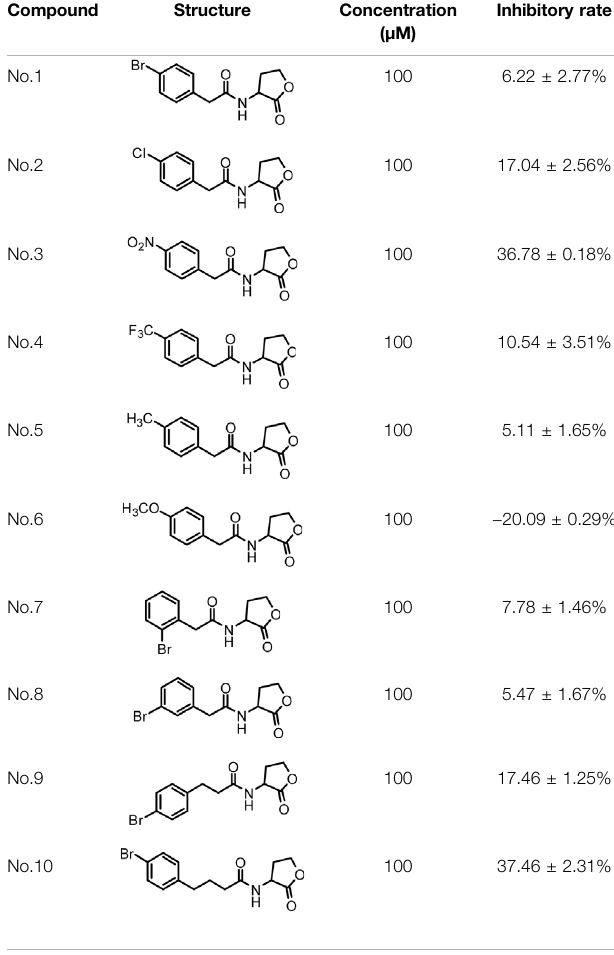
TABLE 1 | Inhibitory rate of AHL